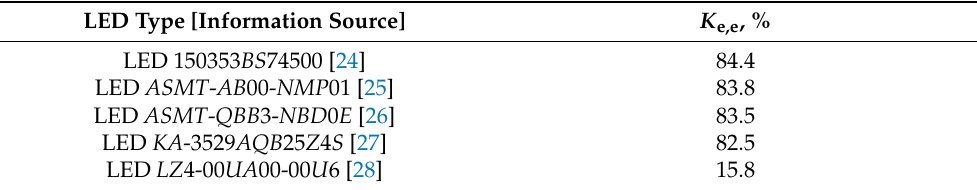
Table 2. Results of calculation of the effective output of LEDs.